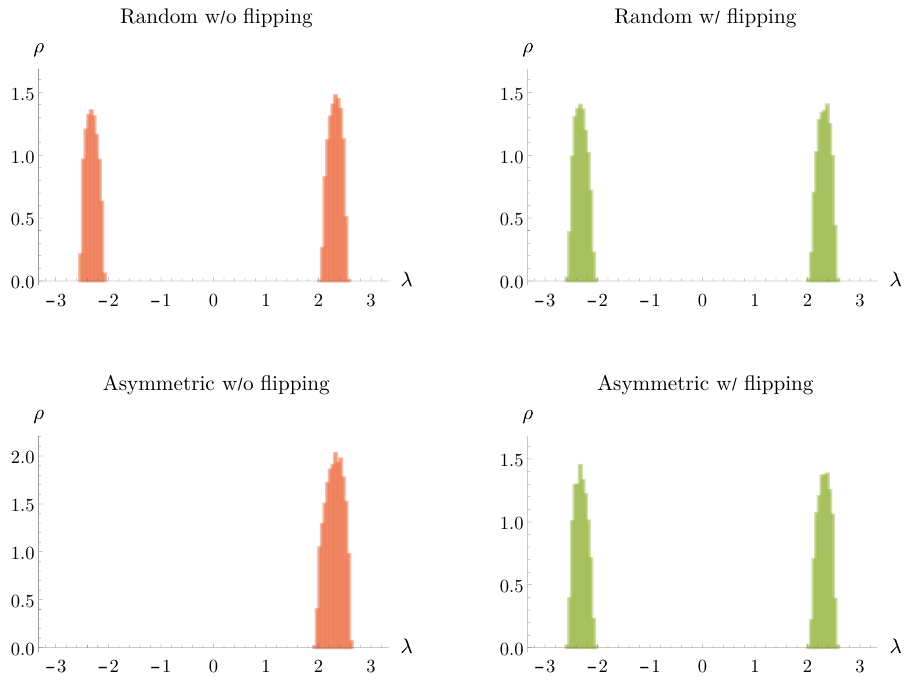
Figure 6 . Eigenvalue-distribution histograms obtained from simulations that were either initial- ized from random configuration or with all eigenvalues in the same potential well (1-cut-asym). The eigenvalue-flipping procedure [31] was either turned on or off. It can be observed that the 1-cut-asym phase is only apparent and vanishes if the system is allowed to tunnel efficiently to the energetically preferred